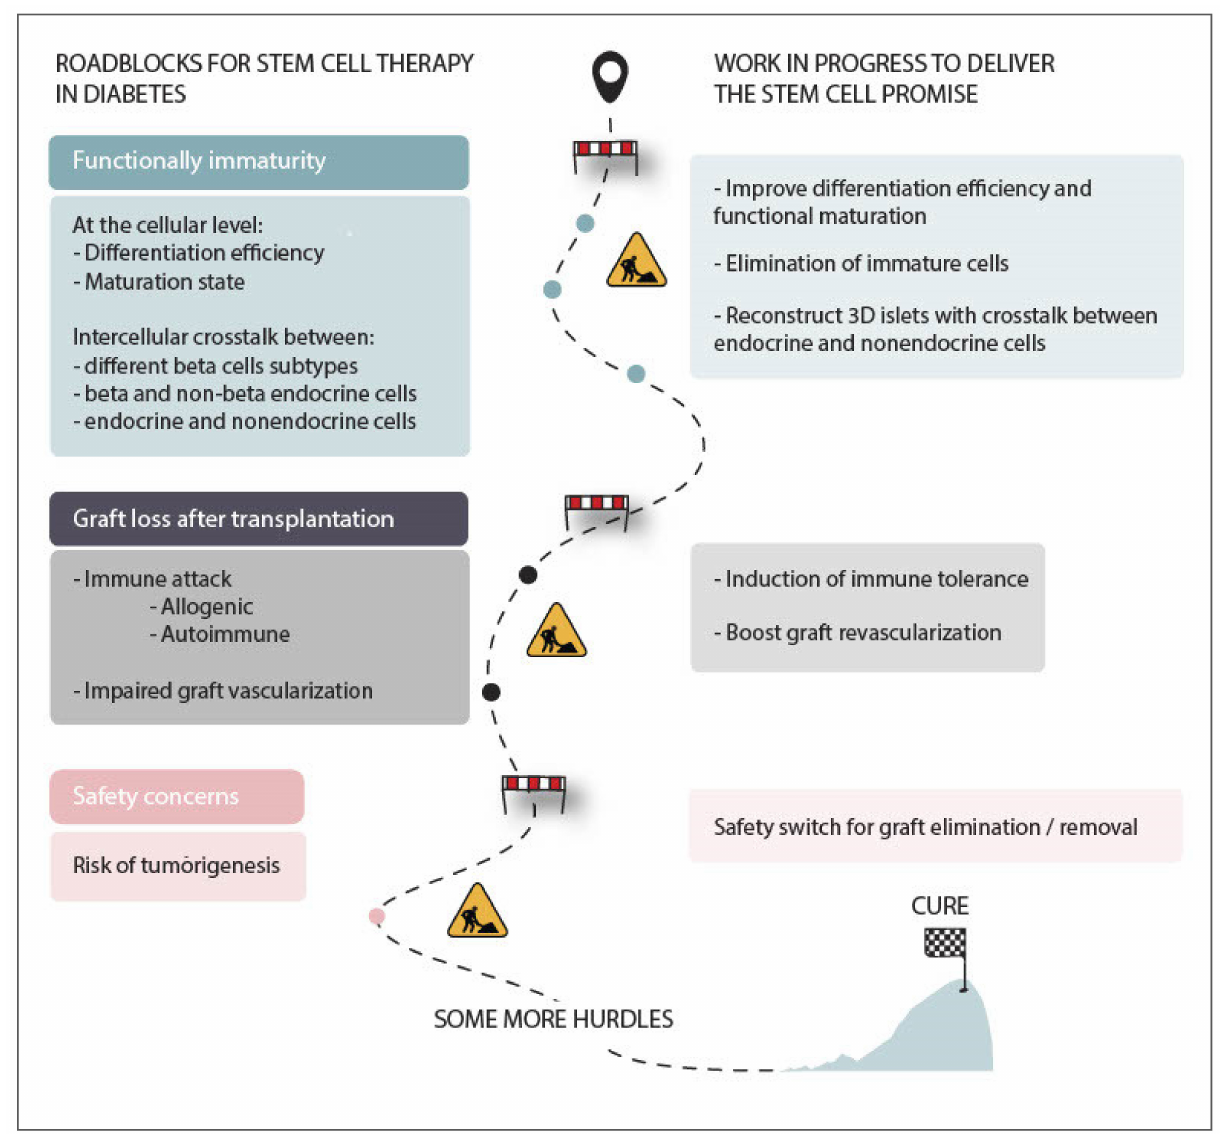
Figure 1. Roadblocks for a functional stem cell-based cure for diabetes. Stem cell-derived beta cells represent a promising alternative beta cell source for transplantation with the potential to cure various forms of diabetes. Nonetheless, major hurdles refrain stem cell-derived beta cells from providing a universal cure for diabetes. The functional maturation of stem cell-derived beta cells remains inferior compared to genuine beta cells, most likely due to the discrepancy of